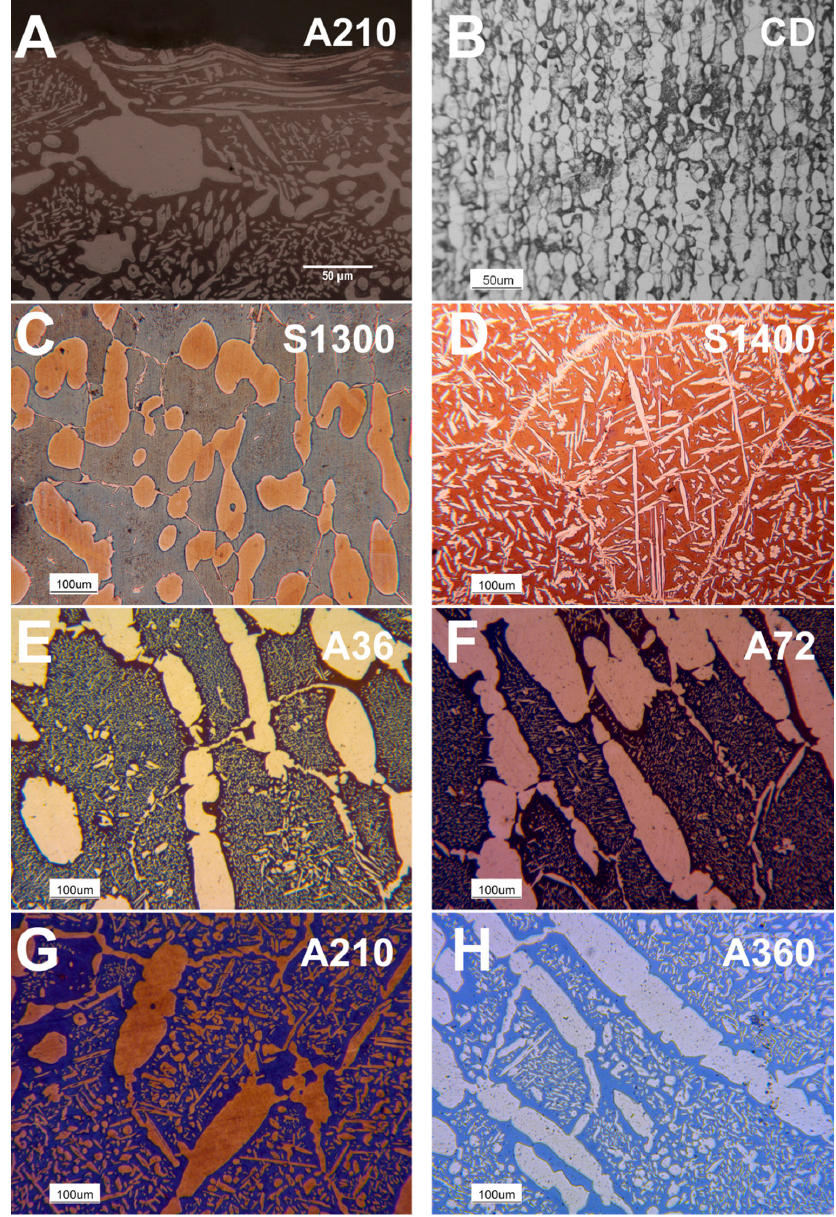
Figure 1. Sample microstructure through optical microscopy after Beraha’s tint etch: Surface section of the sample annealed at 1080 °C for 210 s/mm ( A ); Core section of the cold drawn reference specimen the sample annealed at 1080 ◦ C for 210 s/mm ( A ); Core section of the cold drawn reference specimen ( B ); The solution annealed at 1300 °C ( C ); The solution annealed at 1400 °C ( D ) and the samples ( B ); The solution annealed at 1300 ◦ C ( C ); The solution annealed at 1400 ◦ C ( D ) and the samples annealed at 1080 °C for 36 s/mm ( E ); 72 s/mm ( F ); 210 s/mm ( G ) and 360 s/mm ( H ). annealed at 1080 ◦ C for 36 s/mm ( E ); 72 s/mm ( F ); 210 s/mm ( G ) and 360 s/mm ( H